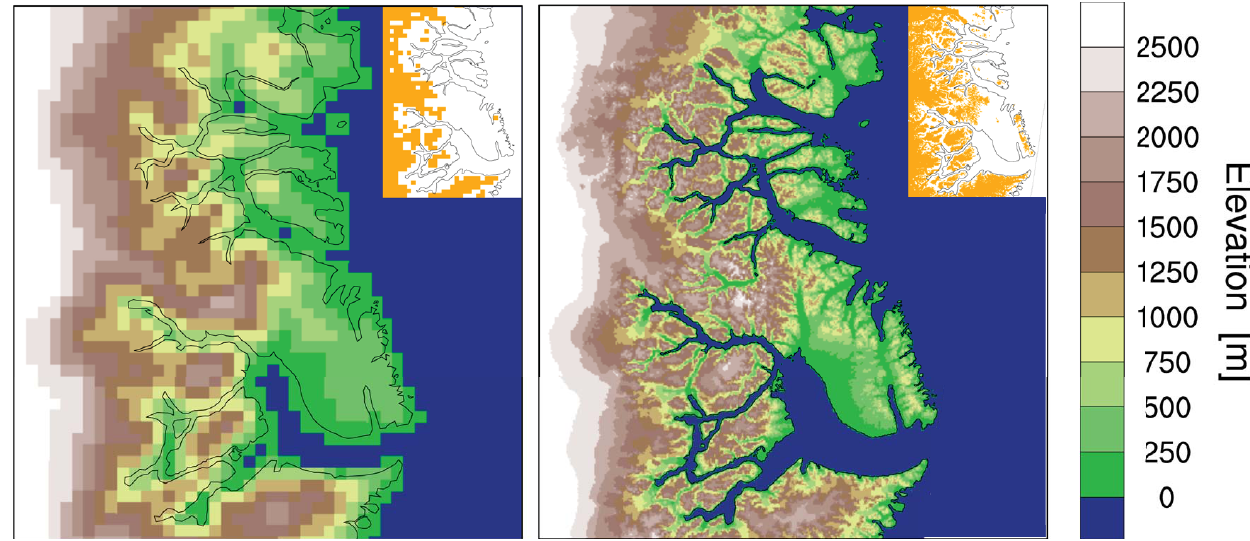
Figure 2. Elevation and ice mask (orange, shown in inset) as prescribed in RACMO2.3 at 11km (left) and derived from the GIMP DEM down-sampled to 1km (right) over central east Greenland (blue box 1 in Fig.